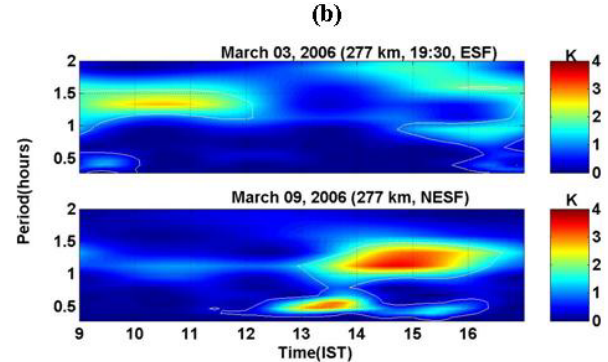
Fig. 2b. Same as in Fig. 2a and for the days given in Fig.